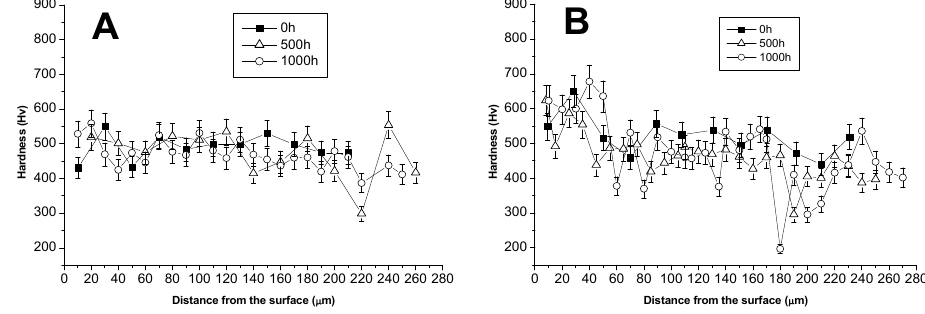
Figure 13. Hardness profile measurement for IN738 + CoNiCrAlY + Pack aluminizing + Post treatment ( A ) and IN738 + CoNiCrAlY + IL aluminizing + post treatment ( B ), respectively, at 0, 500 and 1000 h of isothermal test (1000 °C).